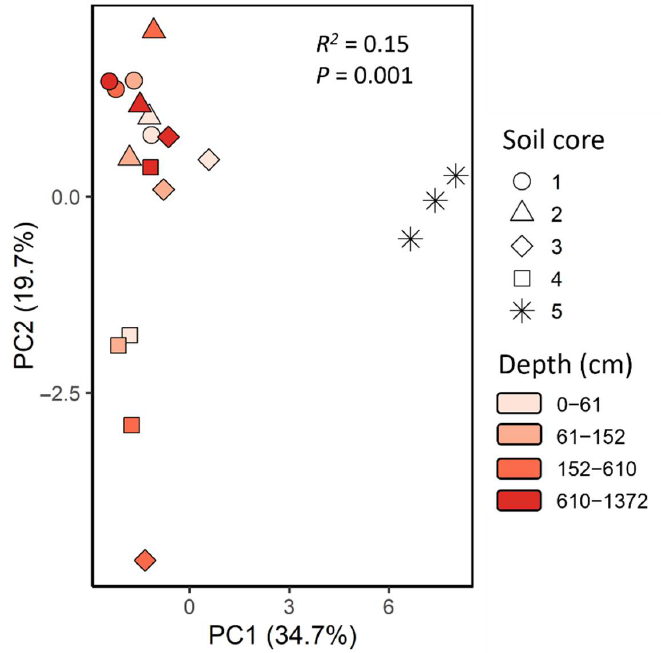
Figure 3. PCA plot showing differences in soil chemical properties at New Afton with changing stockpile depth. PC1 accounts for 34.7% and PC2 accounts for 19.7% of variation observed between soil samples.